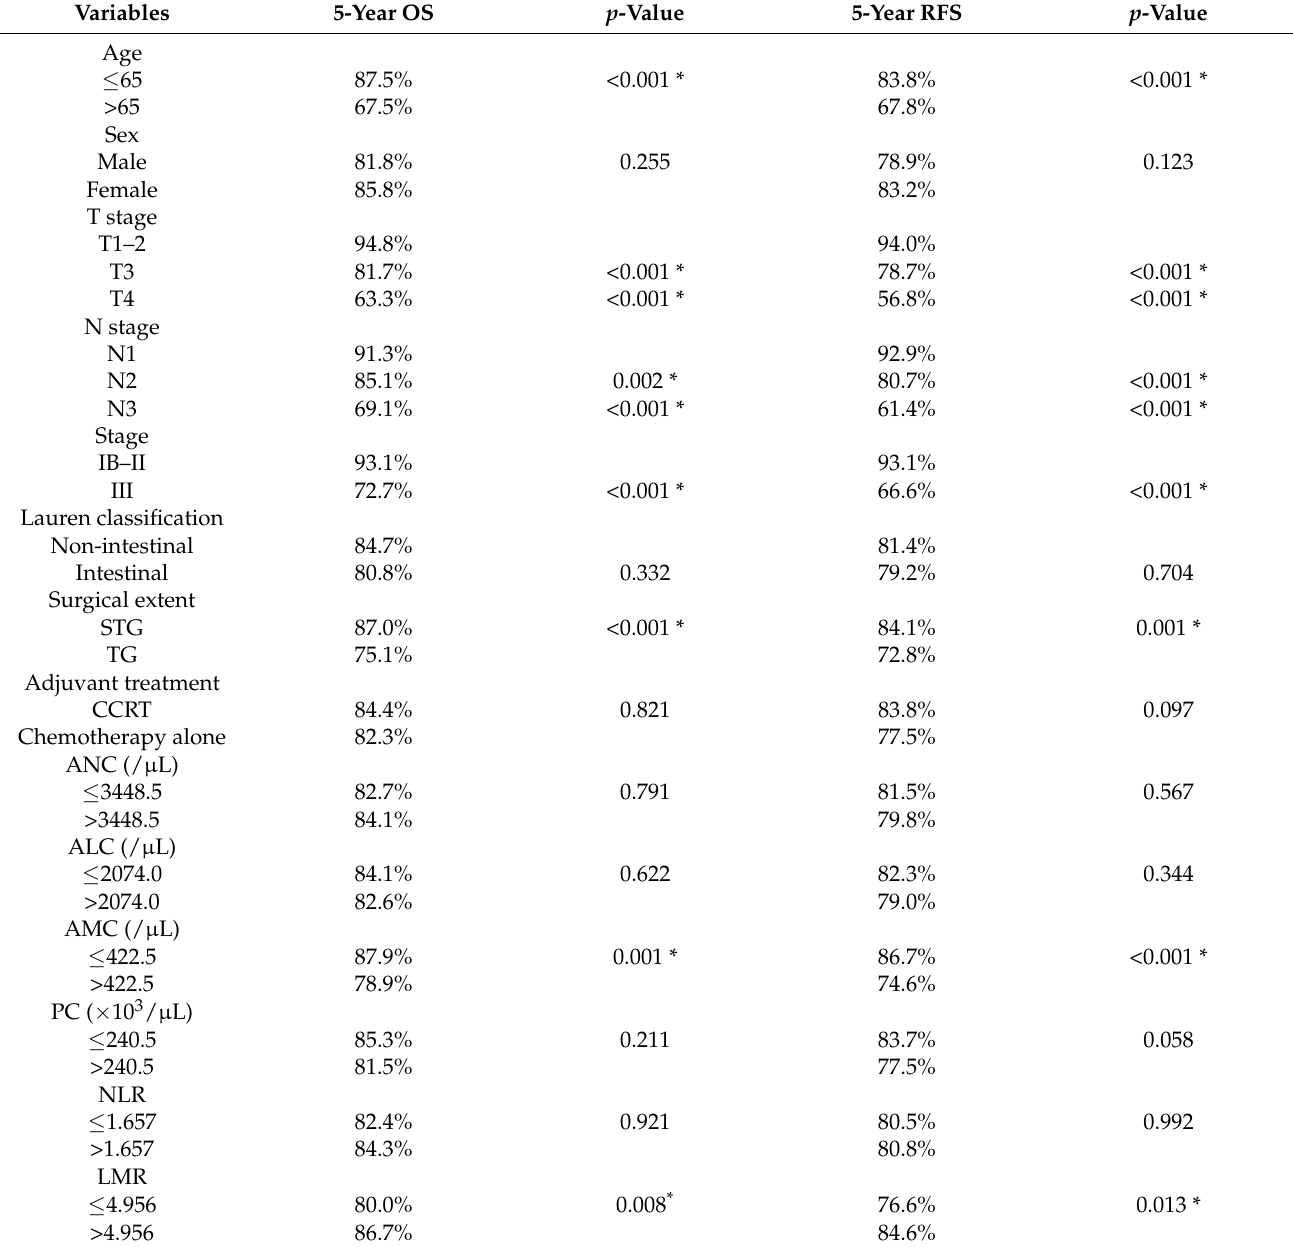
Table 2. Comparison of OS and RFS according to patient